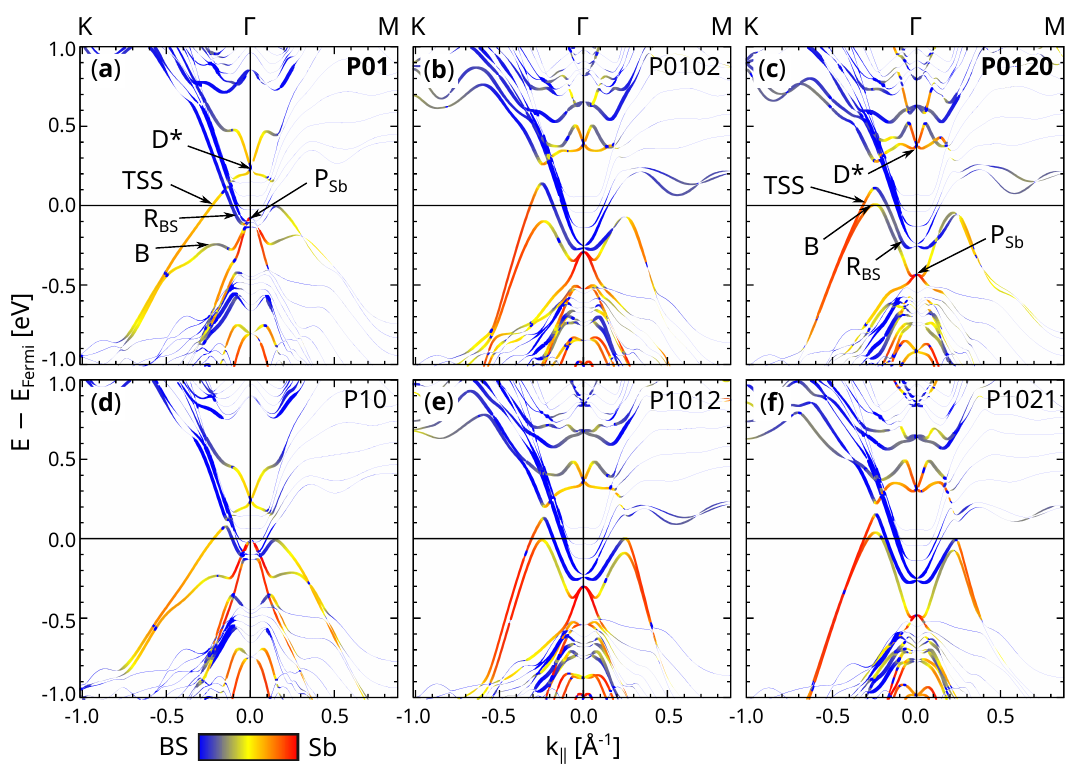
Figure 3. Electronic band structures for the most stable 1BL-Sb@BS and 2BL-Sb@BS structures. The band thickness corresponds to the electronic localization in the upper half of the slab. Bands localized in the Sb (BS) atoms are red (blue). ( a – f ) are the bands for P01, P0102, P0120, P10, P1012, P1021, respectively. Natural stacking order structures are labeled in bold